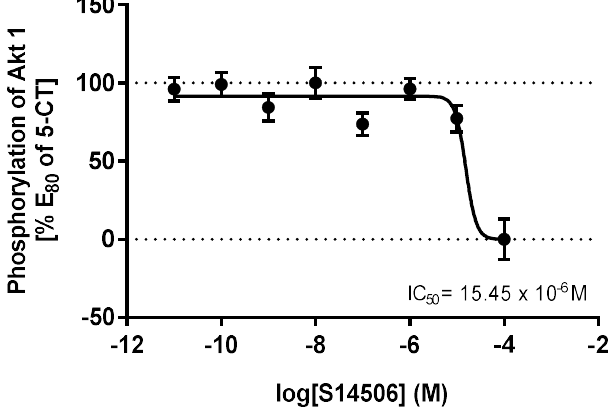
Figure 6. Influence of S14506 on pERK1/2 level in HEK293 cells that overexpress the 5-HT1AR gene.